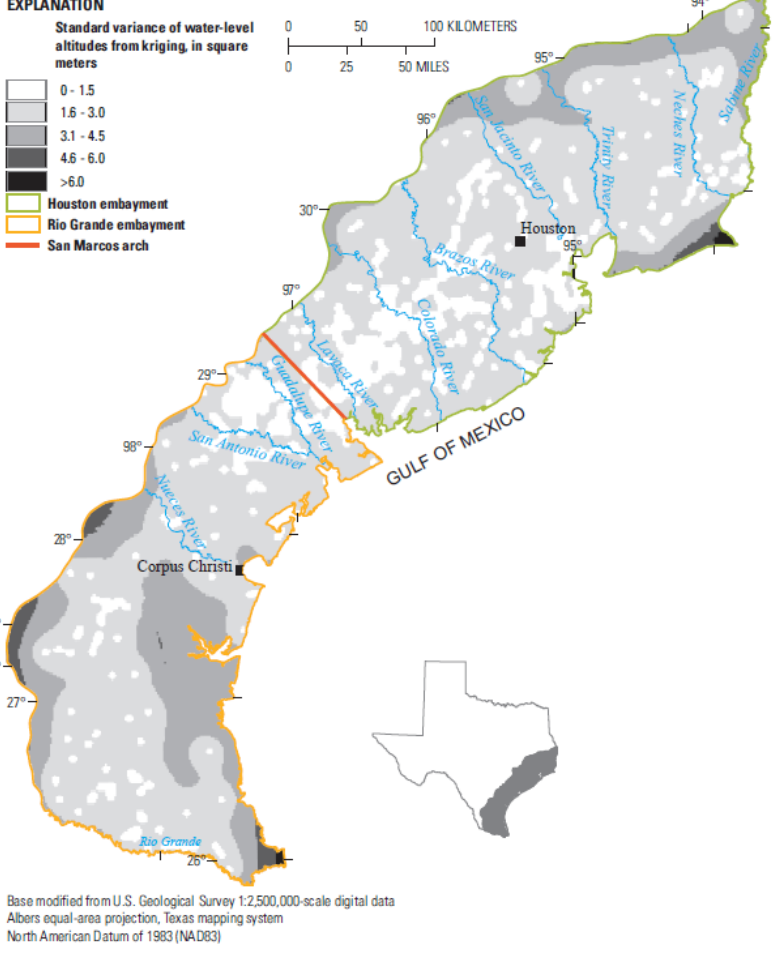
Figure 9. Standard variances of water-level altitudes from kriging within permissive tract 3 within the Texas Coastal Plain.